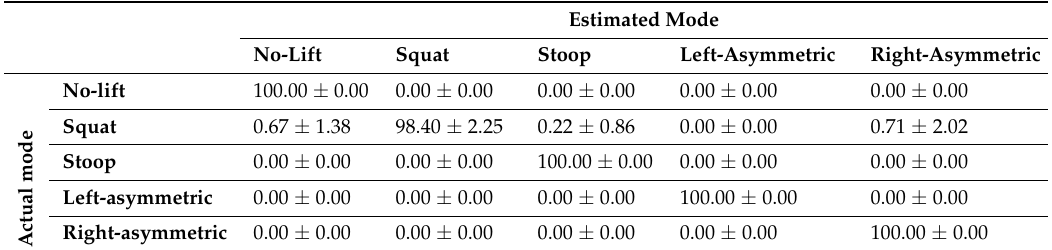
Table 2. Confusion matrix (Mean ± STD) for subject-dependent recognition (%).